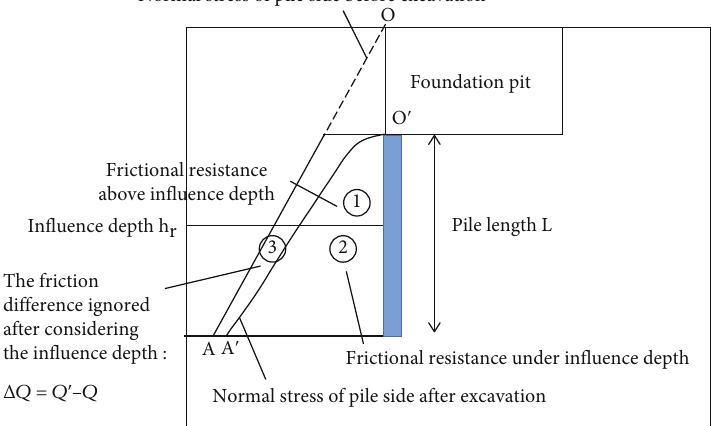
Figure 3: Illustration of the calculation area of pile side friction resistance.